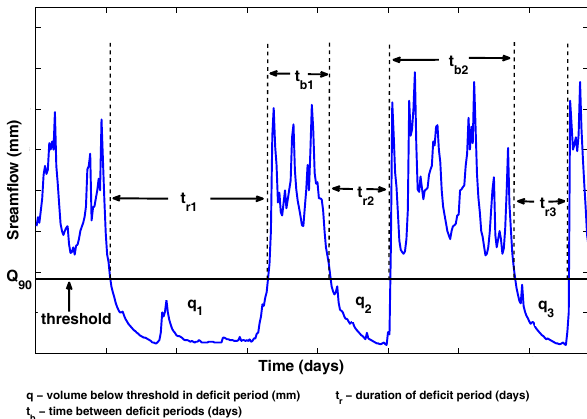
Fig. 4. Definition of deficit, deficit period, and occurrence interval used in low flow